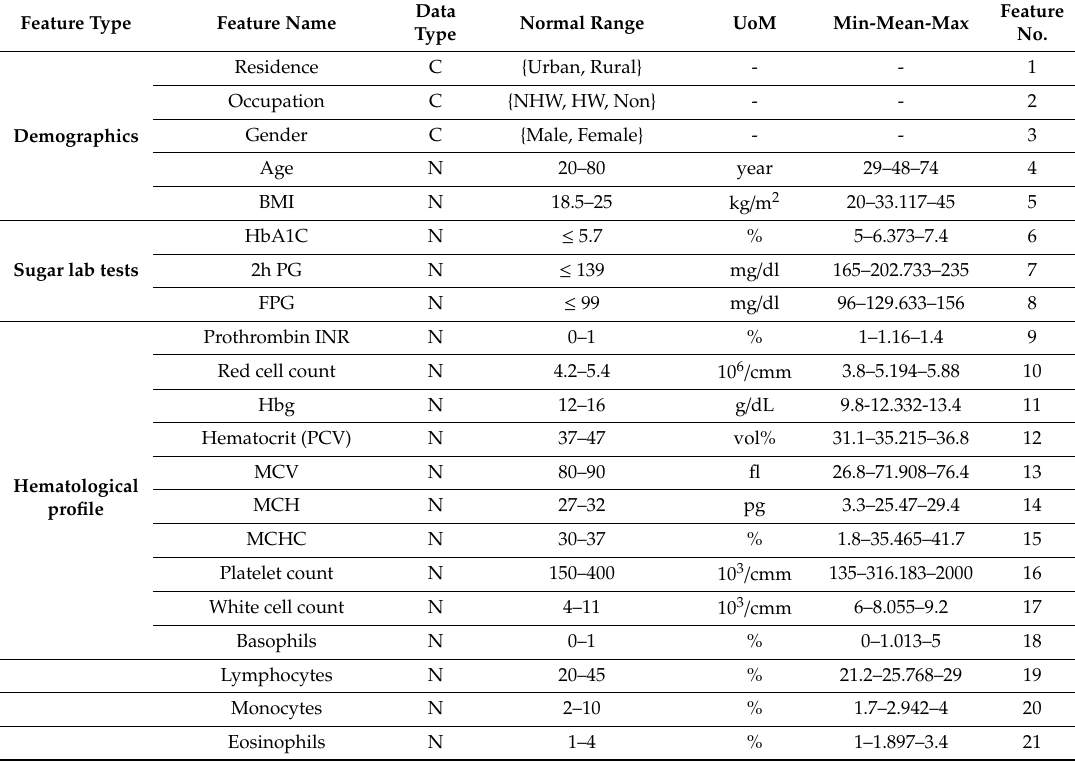
Table 1. Dataset descriptions, where data type is {N = Numerical, C =